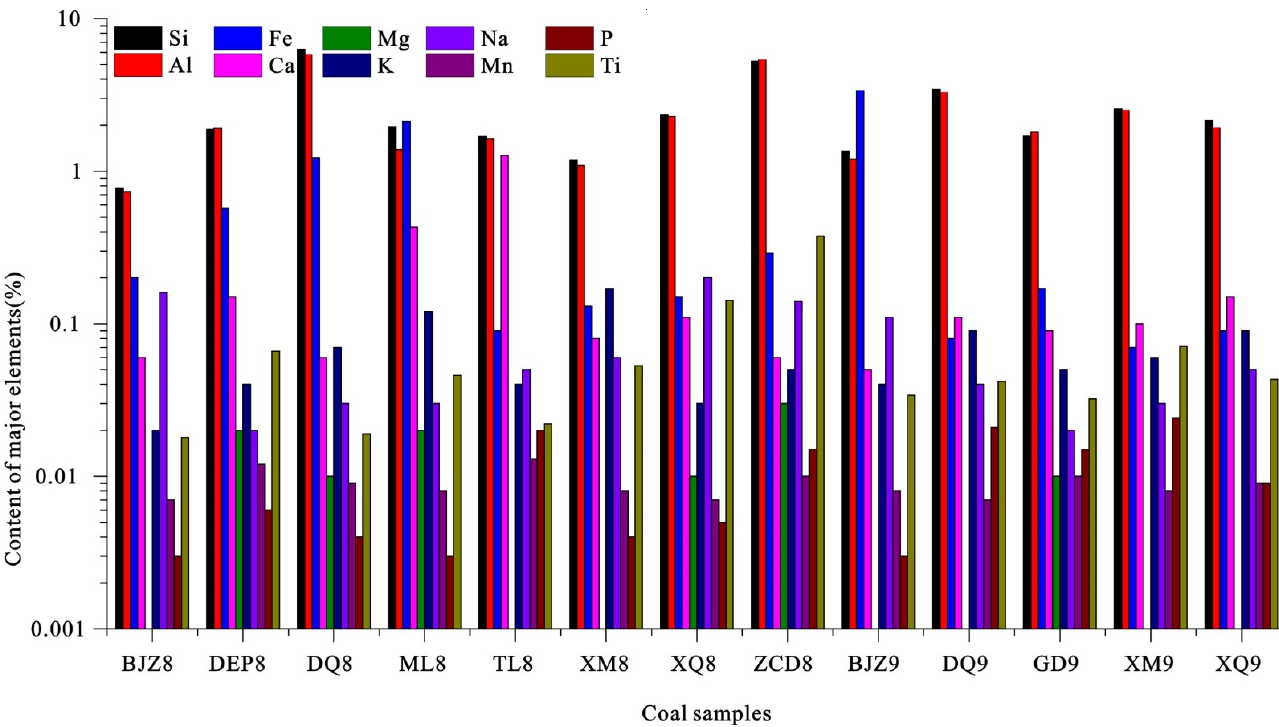
Figure 5. Comparison of major element content of coal sample. Table 2. Major element analysis of coal